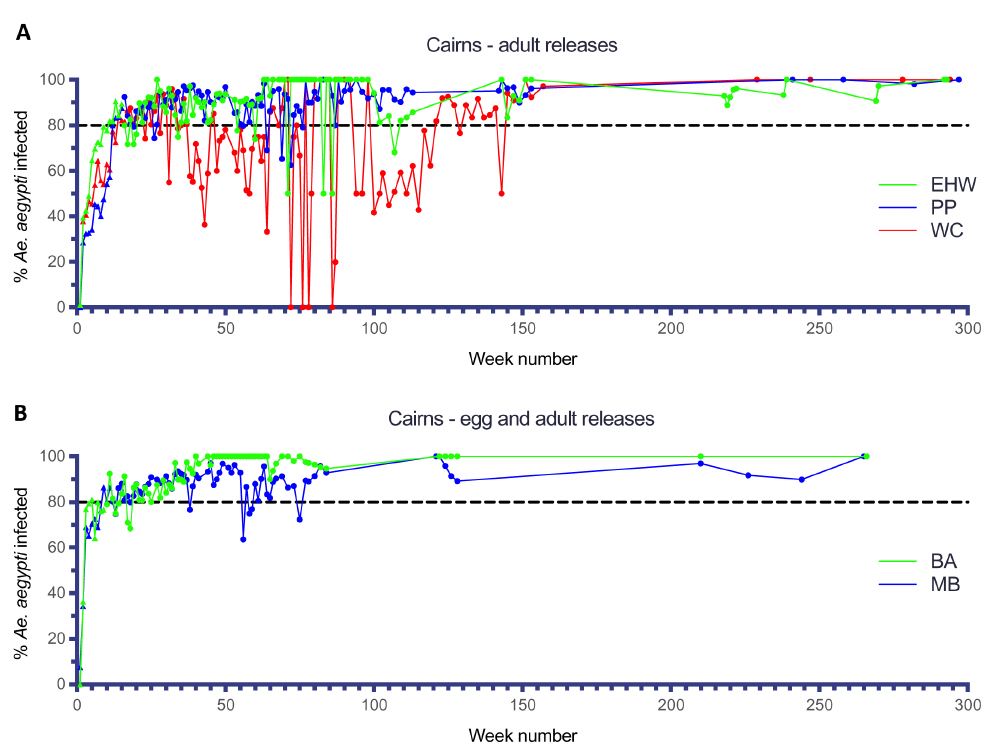
Figure 7. Wolbachia infection rates in Aedes aegypti mosquitoes collected from Edge Hill/Whitfield (EHW), Parramatta Park (PP) and Westcourt (WC) ( A ) and Babinda (BA) and Machans Beach (MB) ( B ) during release (triangles) and post-release (circles) monitoring periods ( Wolbachia infected adult releases were undertaken weekly for 15–16 weeks between Jan–Apr 2013 in EHW, PP and WC; Wolbachia infected adult and egg stage releases undertaken weekly for 9–11 weeks between Jul–Sep 2013 in BA and MB, Week number 1 corresponds to commencement of Wolbachia mosquito releases in each